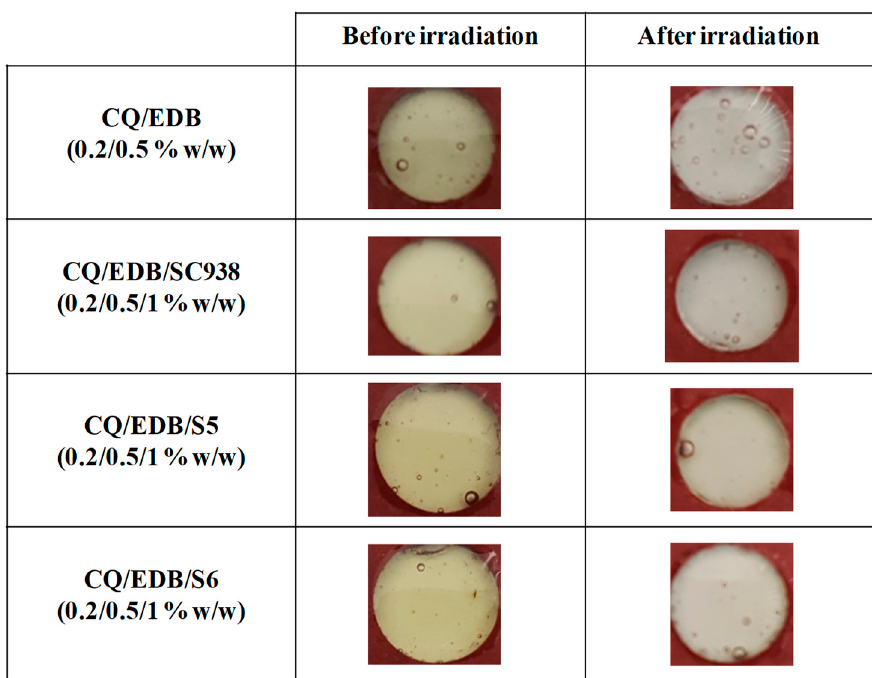
Figure 6. Photos of the samples before and after polymerization (under air; thickness = 1.4 mm; SmartLite Focus (300 mW · cm − 2 ); 115 s irradiation): (1) CQ / EDB (0.2 / 0.5 % w / w); (2) CQ / EDB / SC938 (0.2 / 0.5 / 1 % w / w ); (3) CQ / EDB / S5 (0.2 / 0.5 / 1 % w / w ); (4) CQ / EDB / S6 (0.2 / 0.5 / 1 % w / w ) in Spectrum ® TPH ® 3.